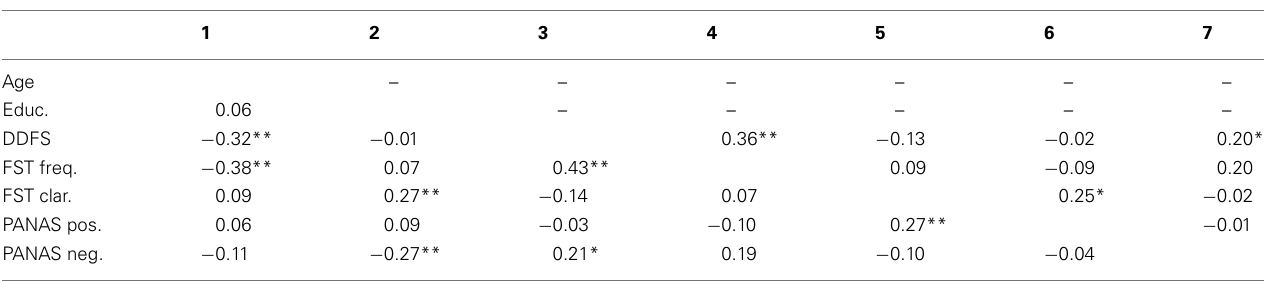
Table 4 | Correlation matrices of study 1A variables ( N = 100,